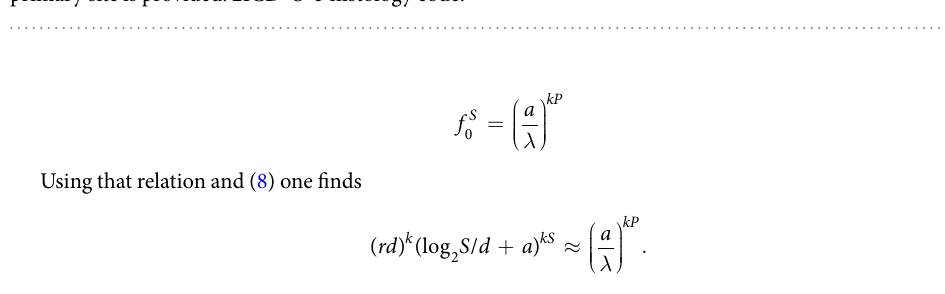
Table 3. Manually curated cancer definitions. 1 Either ICD-O-3 site code or ICD9 code describing tumor primary site is provided. 2ICD-O-3 histology